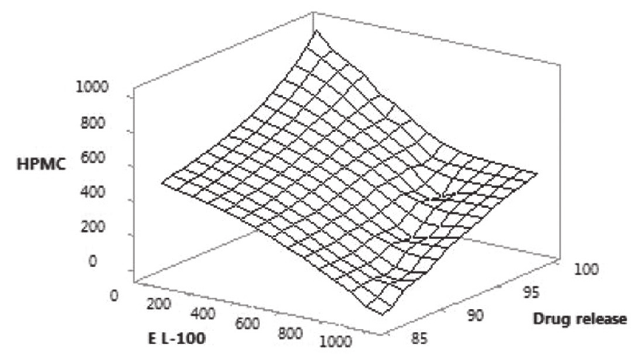
FIGURE 4 - 3-D plot of in vitro drug release study of formulations at t